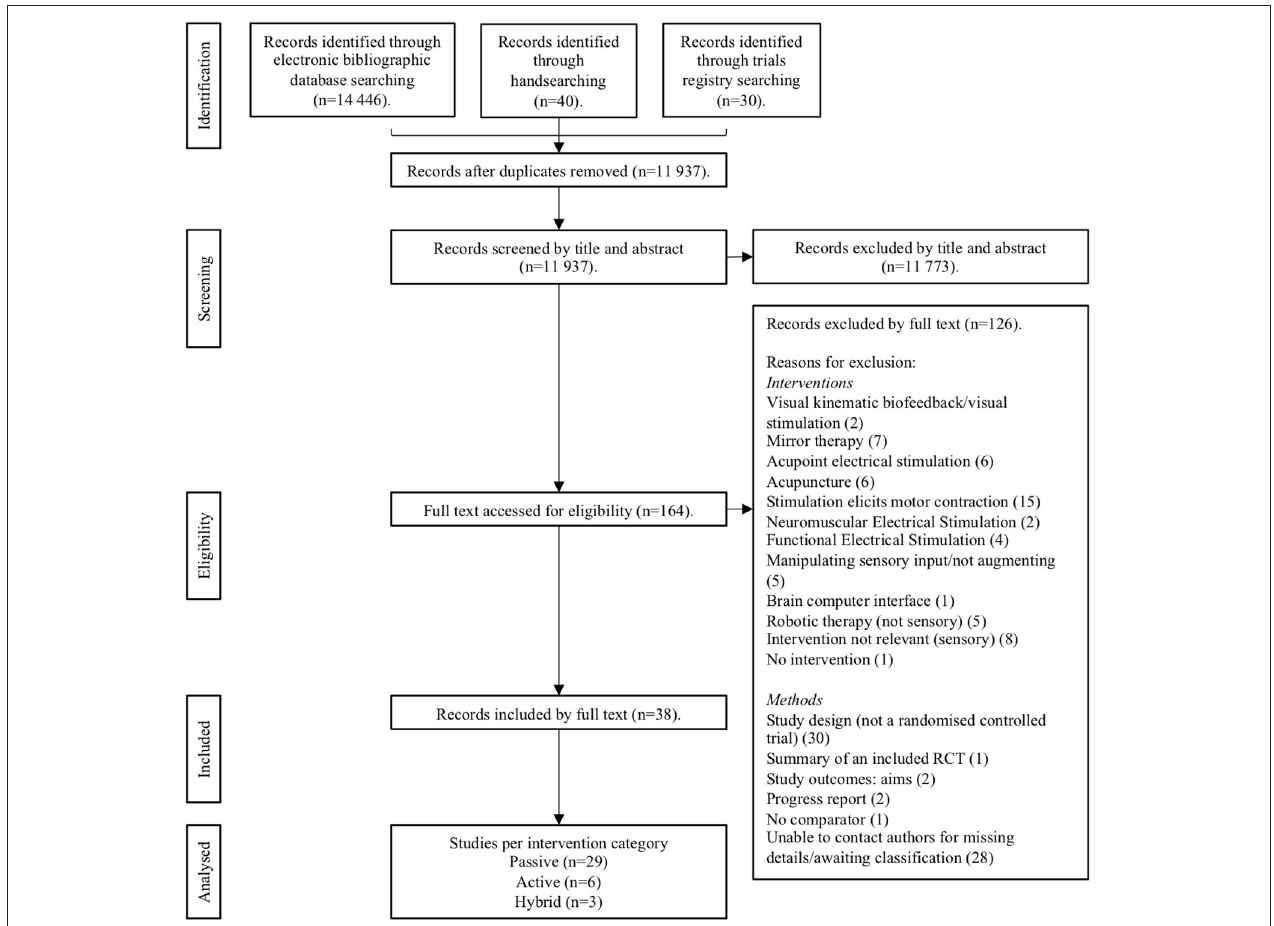
FIGURE 1 | Preferred Reporting for Systematic Reviews and Meta-Analyses (PRISMA) flow diagram of the review